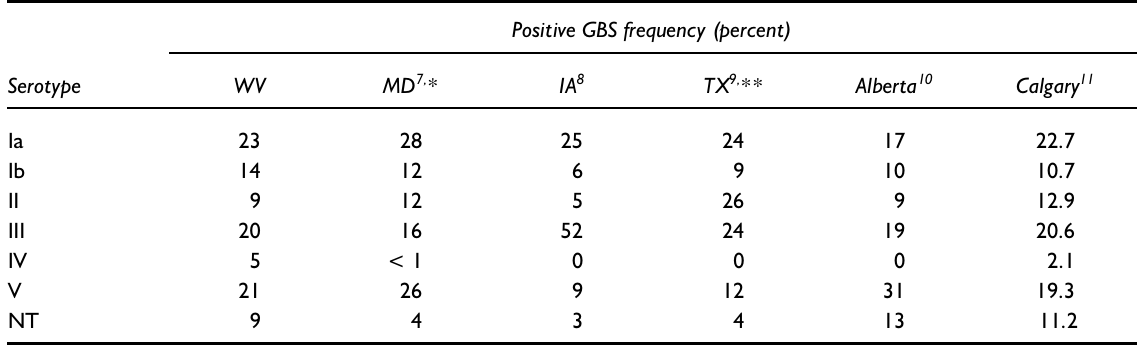
Table 2 Comparison of GBS serotype frequencies between Huntington, WV and other North American